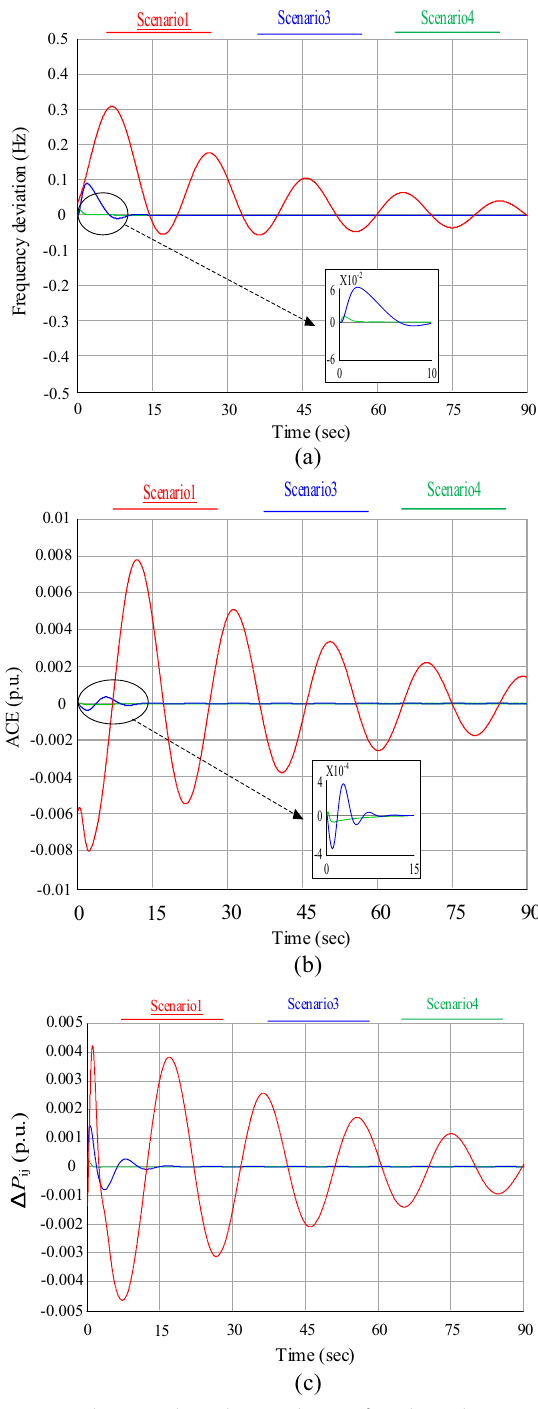
Fig. 9 Simulation results under step change of wind speed, a system frequency deviation, b ACE deviation of area one, c power